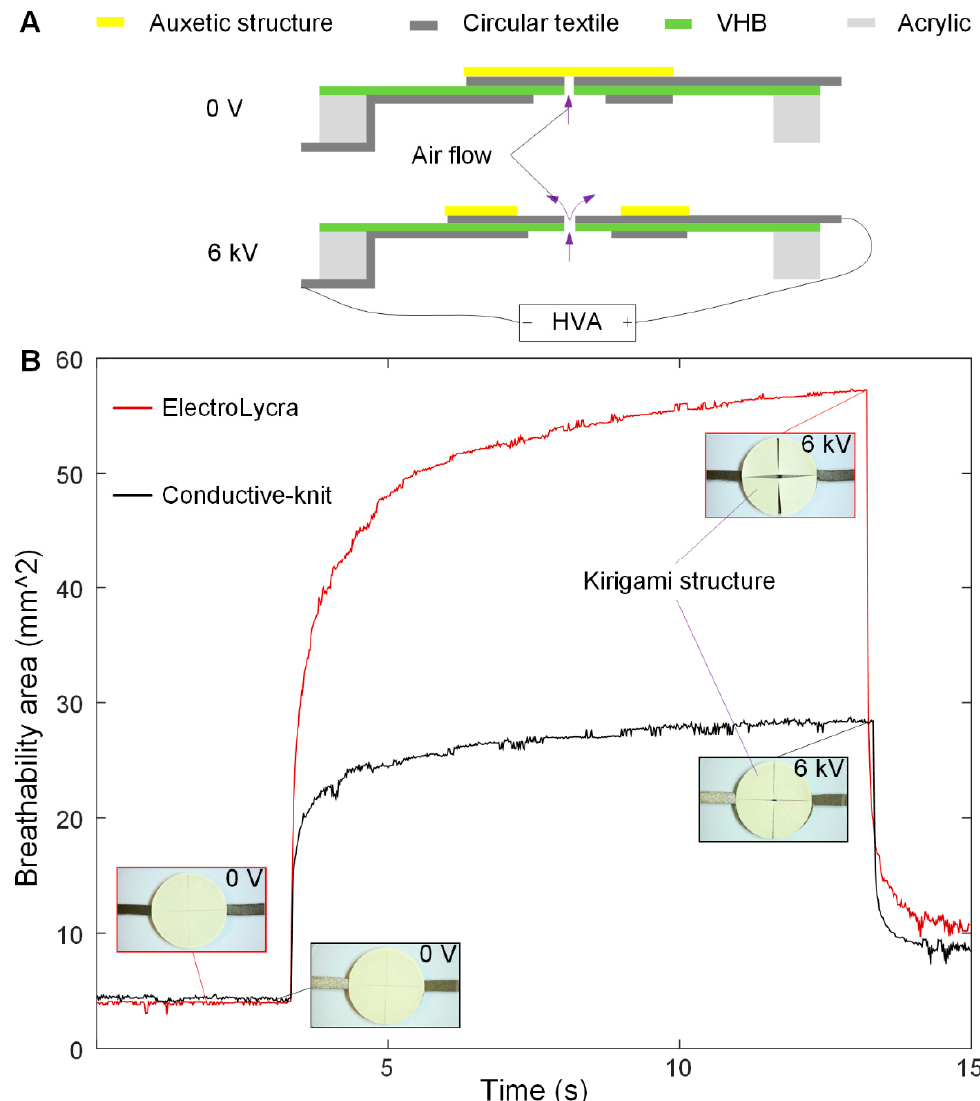
Figure 5. E-textile driven DEA breathability control devices. ( A ) Schematic diagram of the working principle of the device. ( B ) Dynamic breathability area changes of the ElectroLycra and Conductive-knit textile breathability control devices at 6 kV.